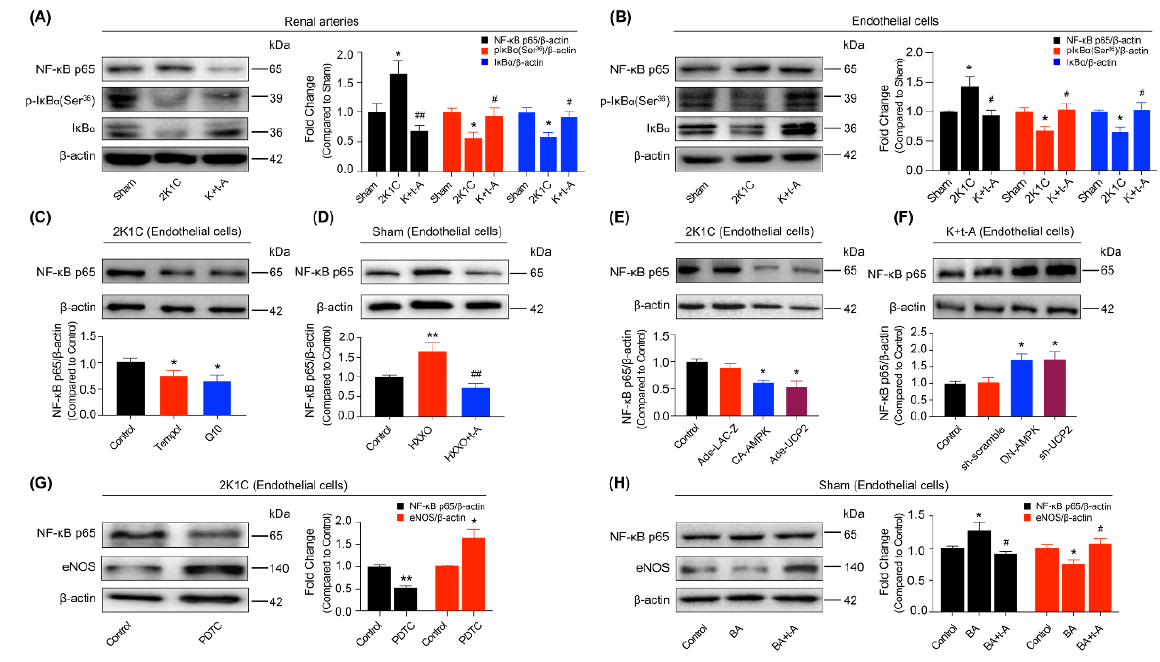
Figure 5. The suppression of NF- κ B contributed to the amelioration of renal endothelial dysfunction induced by t-AUCB in hypertensive rats. The expression of NF- κ B p65 and the expression and phosphorylation of I κ B α (Ser 36 ) in the renal arteries ( A ) and in the endothelial cells ( B ) from Sham, 2K1C, and 2K1C + t-AUCB (K + t-A) rats. The p65 expression in 2K1C hypertensive renal endothelial cells incubated with Tempol (1 µ mol/L) and coenzyme Q10 (20 µ mol/L) in 2K1C rat renal endothelial cells ( C ). The effect of t-AUCB on p65 expression in Sham rat renal endothelial cells treated with ROS inducer, 100 µ mol/L hypoxanthine, plus 0.01 U/mL xanthine oxidase (HXXO) ( D ). The levels of p65 in the 2K1C rat endothelial cells infected with CA-AMPK or UCP2-expressing adenovirus ( E ) and in the 2K1C + t-AUCB rat endothelial cells under the treatment of DN-AMPK or sh-UCP2 adenovirus ( F ). Levels of p65 and eNOS in the 2K1C endothelial cells cultured with PDTC (100 µ mol/L) ( G ). t-AUCB co-treatment to the Sham rat endothelial cells reduced the elevated p65 level and enhanced the down-regulated eNOS protein expression induced by NF- κ B activator BA (100 nmol/L) ( H ). n = 4–9 per group. Data are presented as mean ± SEM. * p < 0.05, ** p < 0.01 vs. Sham or respective control; # p < 0.05, ## p < 0.01 vs. 2K1C, HXXO, or